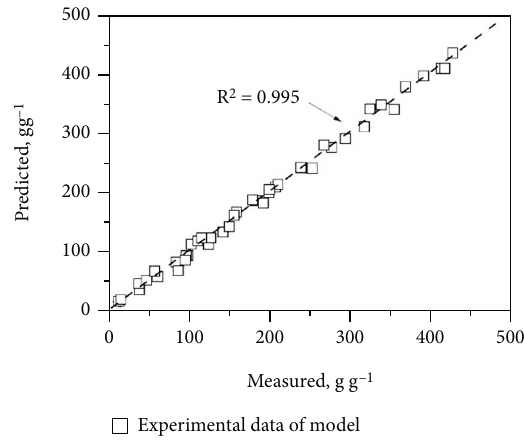
Figure 5: Prediction model for the swelling of acrylic